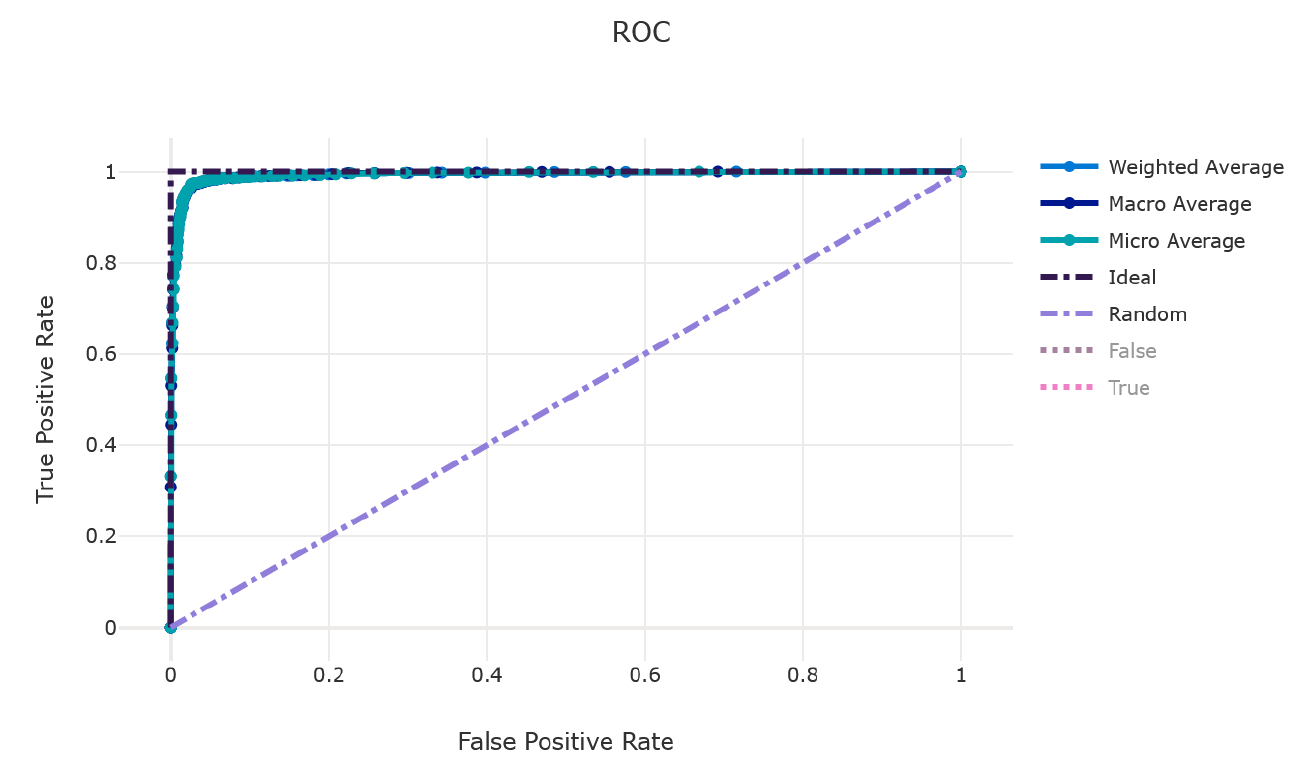
Figure 7. Precision–recall.